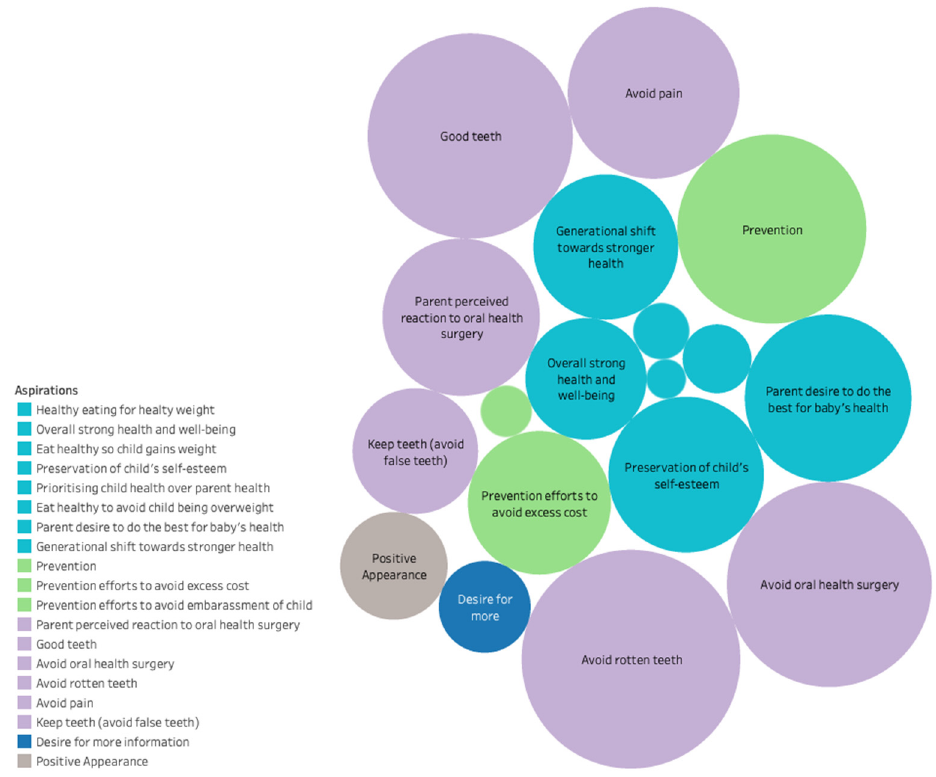
Figure 1. Parental aspirations contributing to intrinsic motivation. Note: The size of each bubble corresponds to the number of parents that discussed a given theme. Where more than one bubble has the same colour, the colour relates to general categories: purple with oral health, turquoise with general health, green with prevention, and grey with appearance.